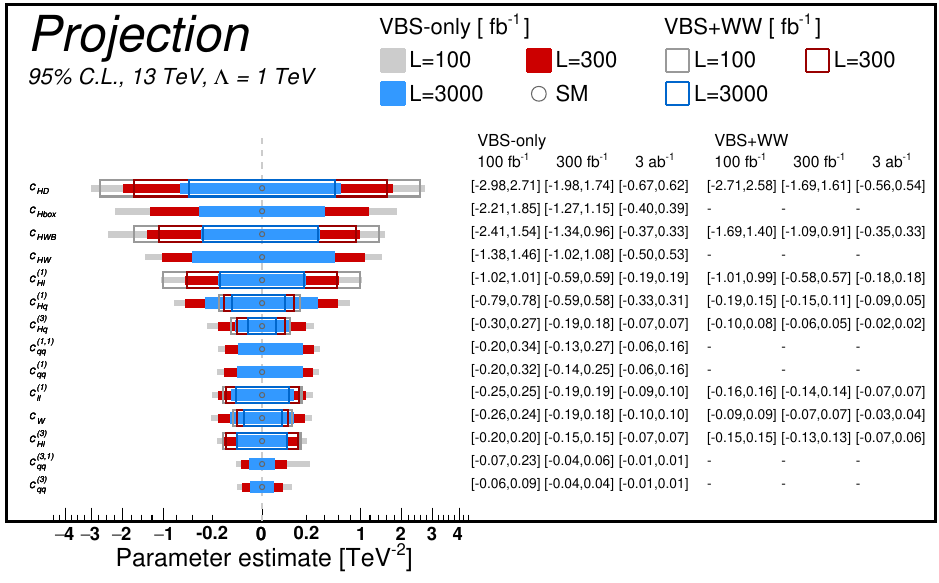
Figure 10 . Expected 95% c.l. constraints on individual SMEFT operators for an integrated luminosity of 100 fb − 1 (grey), 300 fb − 1 (red) and 3 ab − 1 (blue). Constraints expected from the combination of the VBS channels SSWW+2j, OSWW+2j, WZ+2j, ZZ+2j are depicted as filled colored boxes while the combination of VBS and WW channels as hollow boxes with a colored border line. EFT effects in the QCD-induced processes are included whenever relevant. The result for VBS+WW is not indicated for operators that do not enter WW. In this case the limits from the VBS+WW combination would coincide with those from VBS